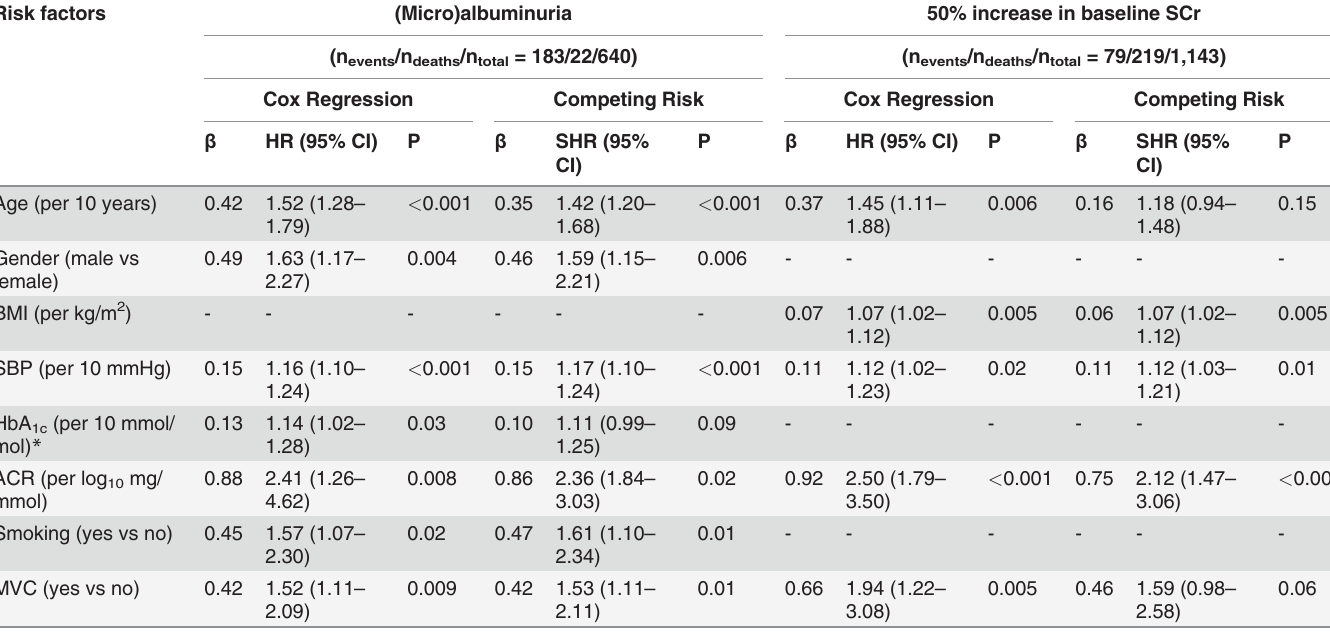
Table 2. Developed risk prediction models for early-stage renal complications ([micro]albuminuria) and late-stage renal complications (50% in- crease in baseline serum creatinine) in patients with type 2 diabetes. Risk factors (Micro)albuminuria 50% increase in baseline SCr (n events /n deaths /n total = 183/22/640) (n events /n deaths /n total = 79/219/1,143) Competing Risk Cox Regression Competing